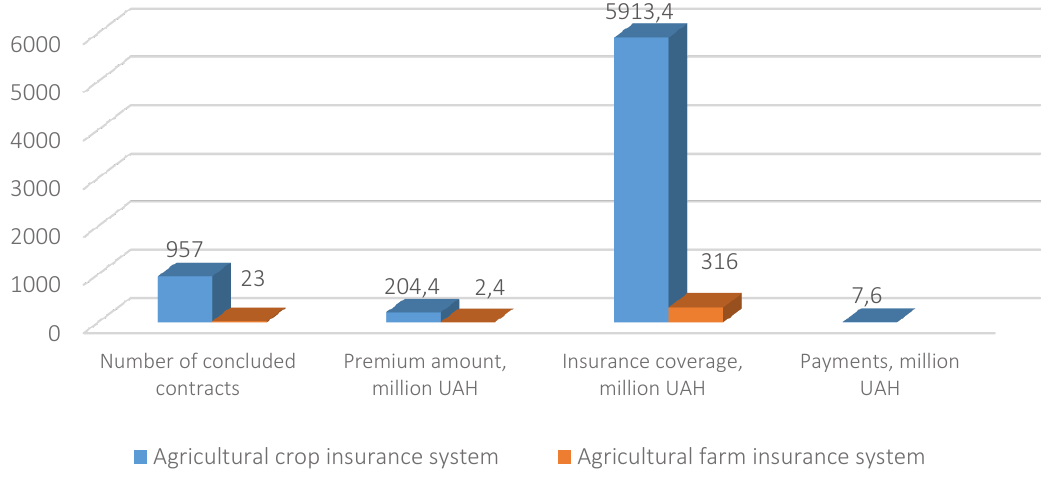
Figure 7. Indicators of the Ukrainian agricultural insurance market in terms of the components of insurance systems